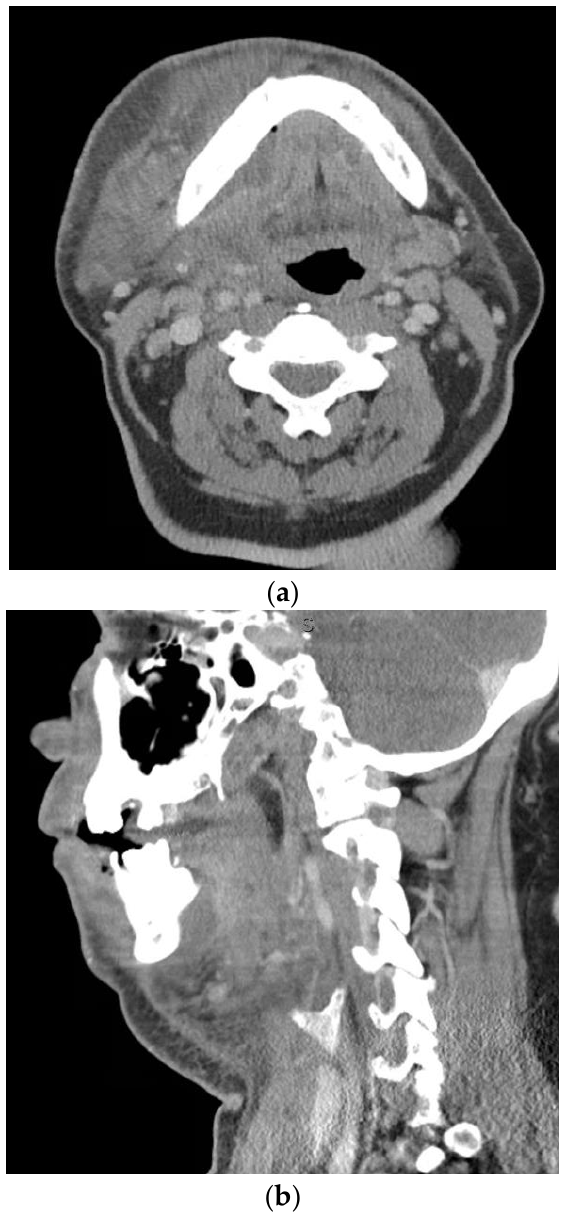
Figure 1. Axial ( a ) and sagittal ( b ) computed tomography scan views of patient with right sub- mandibular, sublingual, and submental abscess with associated odontogenic severity score of six. Certain patient specific factors may create an environment that allows the dissemina- tion of odontogenic infections. Any condition that causes immunosuppression may allow dissemination more rapidly. Perhaps the most common immunosuppressing condition is diabetes. In the United States alone, an estimated 37.3 million people have diabetes [11].